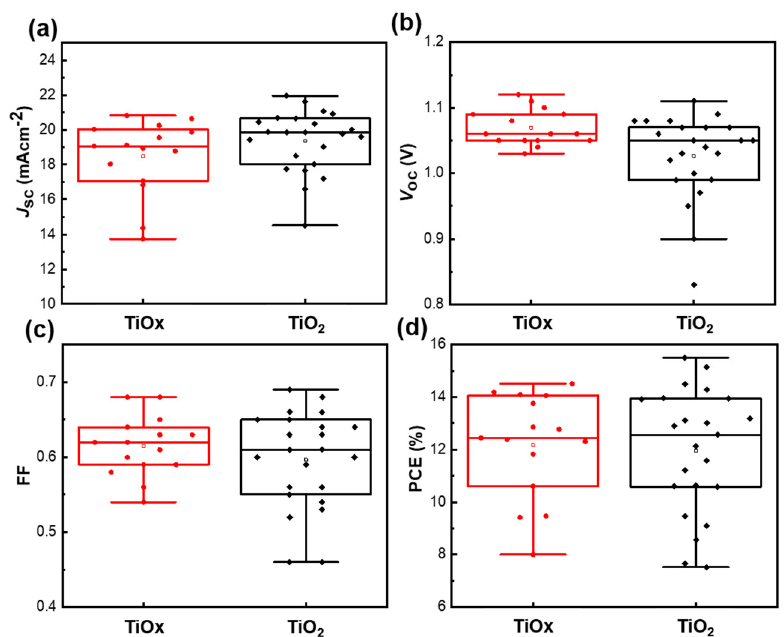
Figure 7. Average ( a ) J sc , ( b ) V oc , ( c ) fill factor (FF), and ( d ) PCE values for devices fabricated with TiO x and TiO 2 films. Error bars indicate ± one standard deviation from the mean.